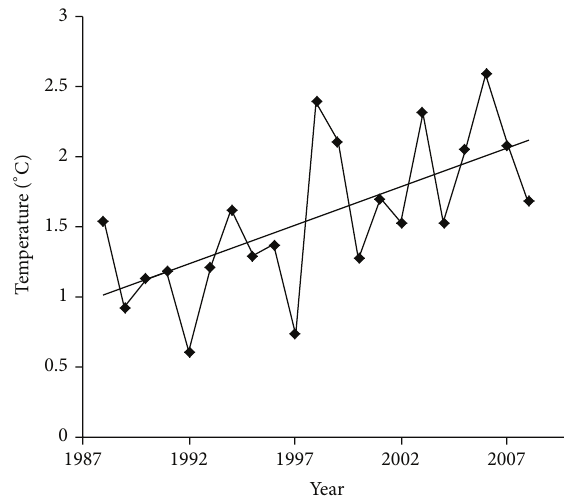
Figure 4: Trend of the variation of annual temperature.